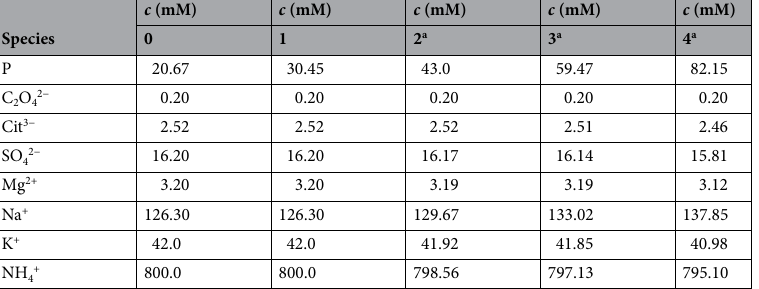
Table 9. The initial concentrations, c , of the individual complexes, taking into account the addition of small volumes of 2 M NaOH (see Table 8) to the samples with P concentrations of 2, 3 and 4, compared to the initial state (concentration 0). The concentrations for 0 and 1 are identical because no NaOH was added to samples 0 and 1. a The calculations took into account the added small amounts of 2 M NaOH (Table 4), which resulted in a slight change in the initial molar concentrations of individual ions compared to samples 0 and 1.